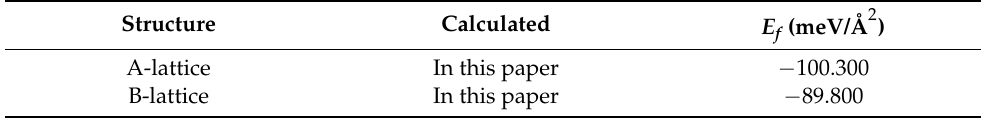
Table 2. Formation energy 𝐸 𝑓 of structures A and B. The energy is in meV/ Å 2 . Table 2. Formation energy E f of structures A and B. The energy is in meV/ A 2 . Structure